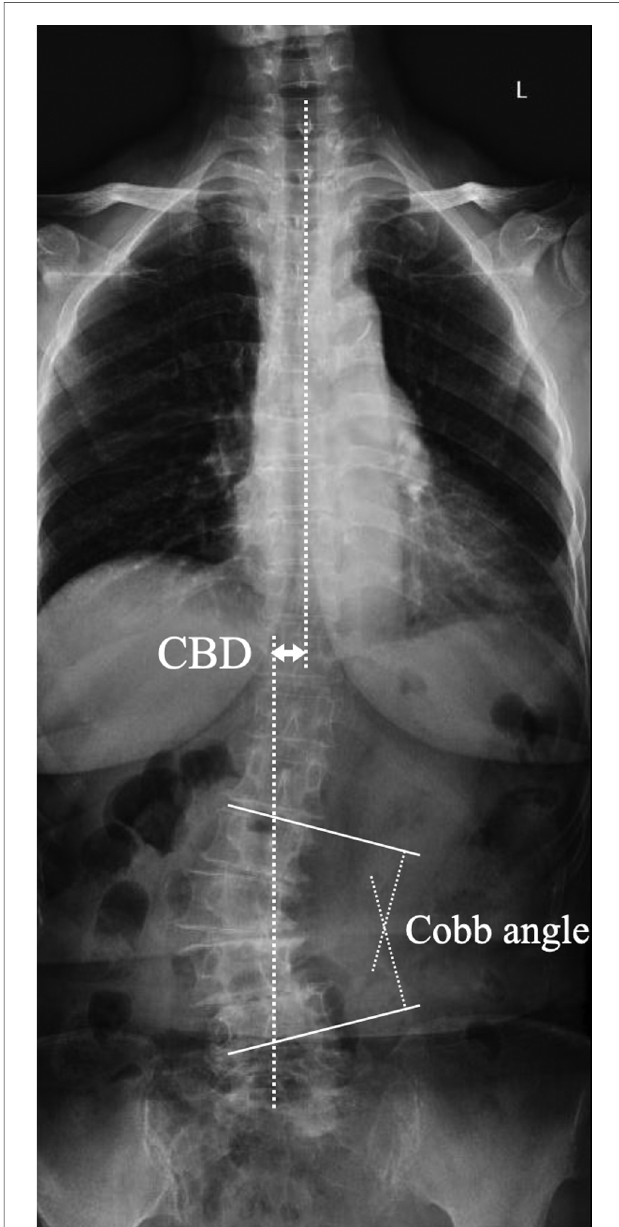
FIGURE 3 Schematic diagram of coronal spinal parameters measurement. Cobb ’ s angle was measured between the most tilted vertebrae. CBD was the distance between C7 plumb line and